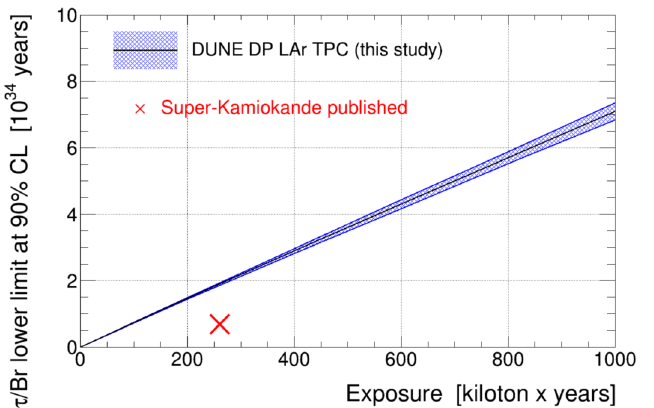
Figure 10 . Lower lifetime limit for τ/ Br ( p → ¯ νK + ) at 90 % CL as a function of exposure as obtained by the presented study. The black line shows the limit for the mean signal selection efficiencies of both samples and the blue band covers the full spread between the samples. The red cross shows the latest published result by Super-Kamiokande [16], see section